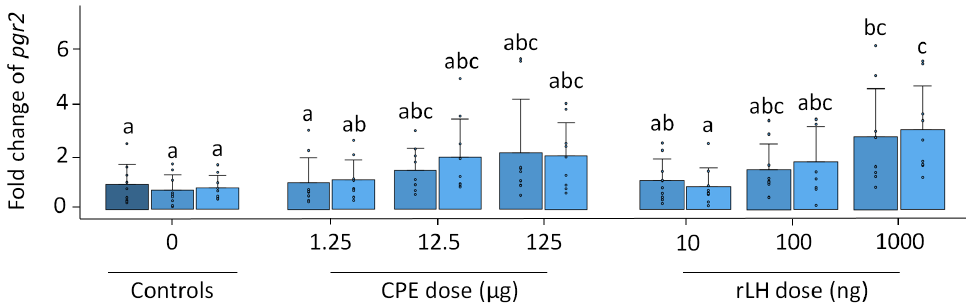
Figure 4. Expression of the nuclear progestin receptor pgr2 when treated with various dosages of CPE (0, 1.25, 12.5 and 125 µg mL −1 ) and rLH (0, 10, 100 and 1000 ng mL −1 ) in vitro at the start of incubation (dark blue) and after 12 (mild blue) and 18 (light blue) hours of incubation. The receptor expression was normalized to the 0 h control and expressed as the fold change. The expression was compared between time points and dosages of CPE and rLH. The expression of pgr2 was upregulated after incubation with 1000 ng rLH after 12 and 18 h incubation when compared to the controls. The bars with no overlap in letters are significantly different from each other ( p < 0.05). Data are presented as bar plots with an average ± standard deviation and individual data points as circles. The experiments were performed on N = 9 eels, with the exception of 100 ng rLH (N = 8 eels).